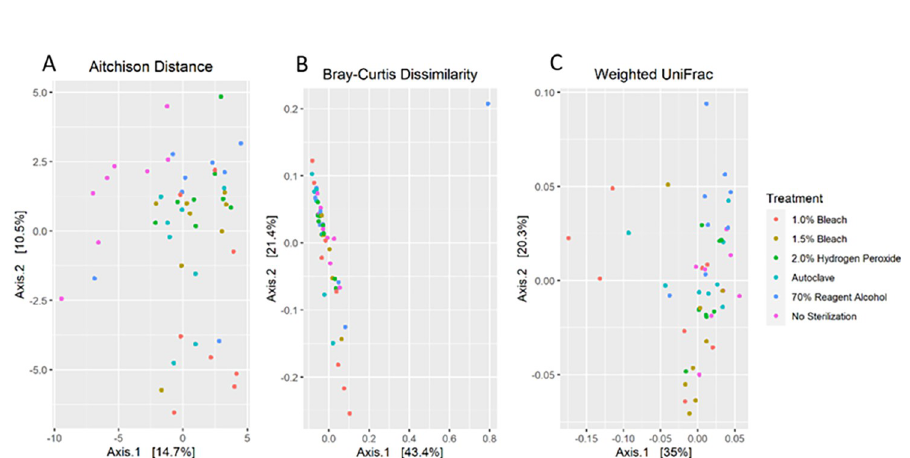
Fig 7. Beta diversity of 24 h simulated in vitro colonic fermentations performed at 37˚C on treated pulses with feces added. (A) Aitchison; (B) Bray-Curtis; (C) Weighted UniFrac beta indices.